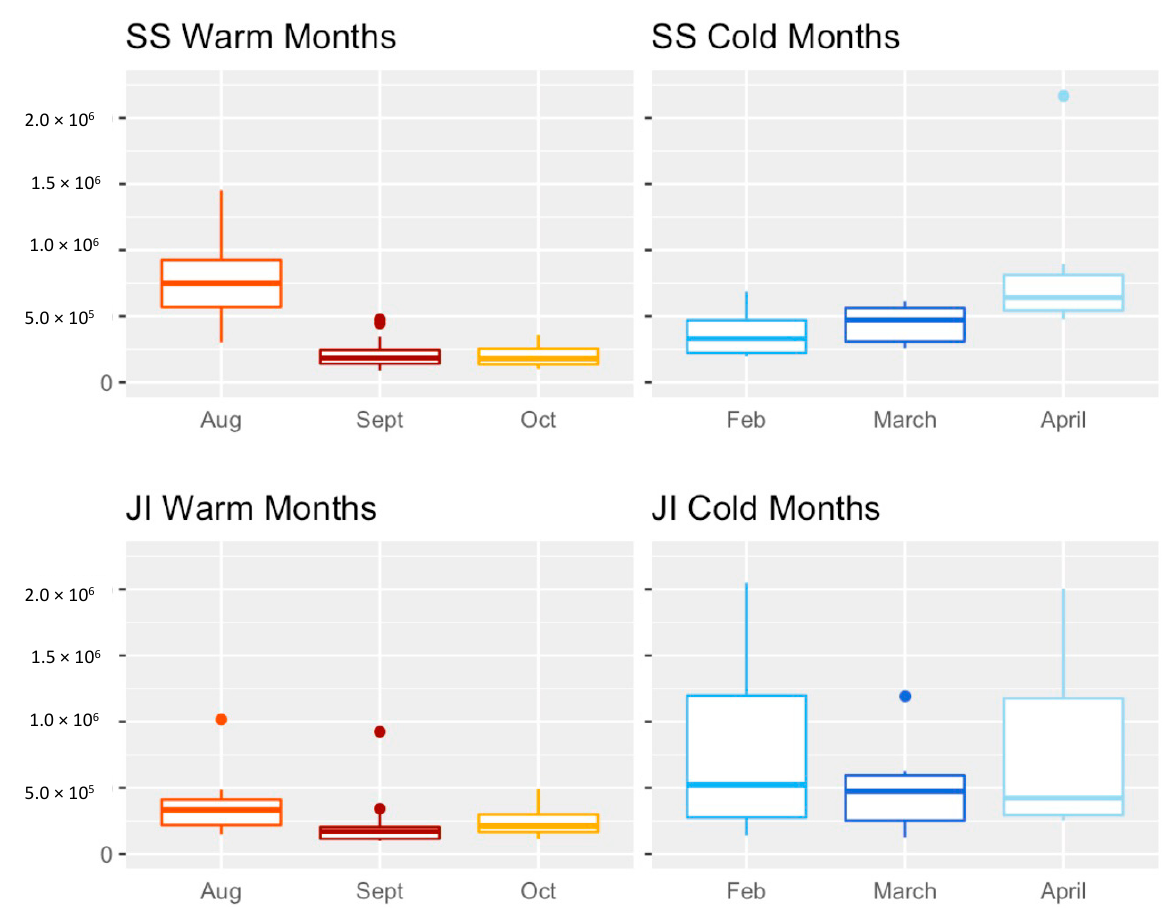
Figure 7. SARS-CoV-2 copies per case during warmest (17.41–19.75 ° C) and coldest months (8.60–12.27 ° C) in SS and JI WWTPs.